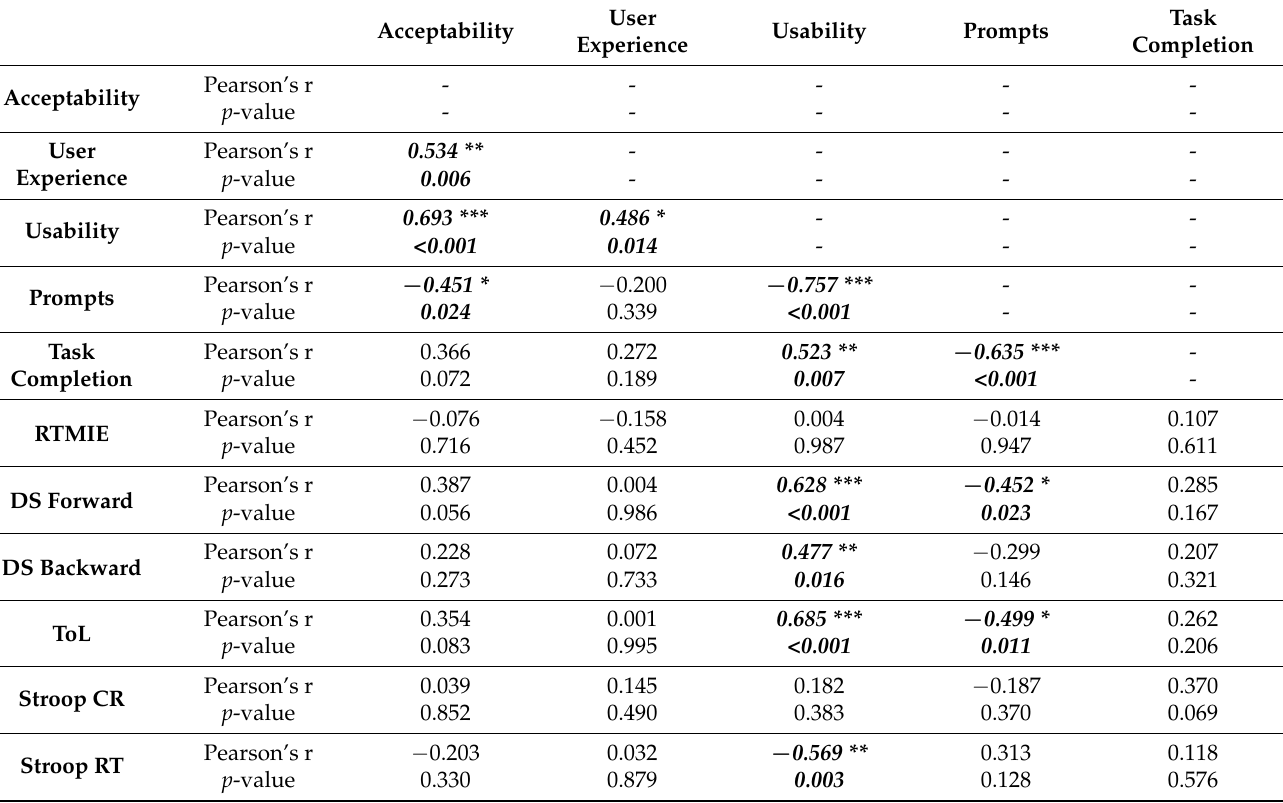
Table 5. Pearson’s correlations between self-reports and performance metrics.